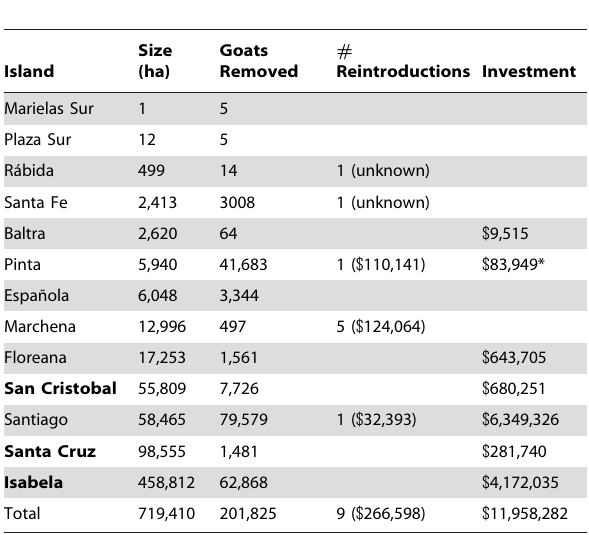
Table 2. The Santiago and Isabela Island goat eradication campaigns during Project Isabela